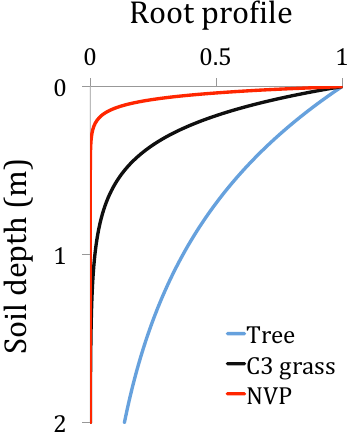
Figure 2. Root profile of boreal broadleaf trees, C 3 grasses and soil water uptake profile for